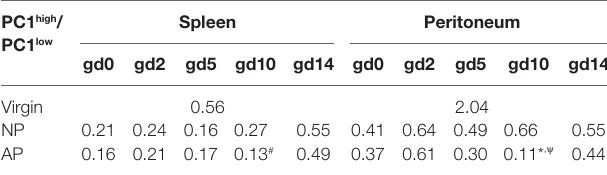
TaBle 2 | The PC1 high /PC1 low ratio was significantly reduced in peritoneum from AP females on gd10. Pc1 high /